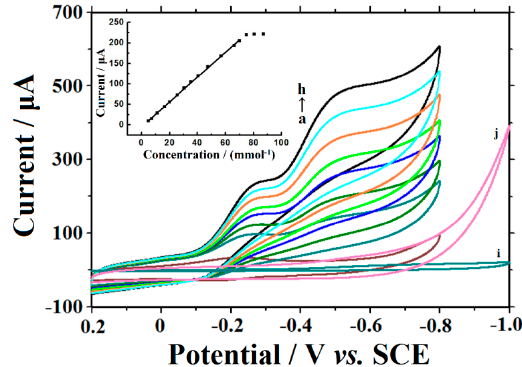
Figure 7. CV of CTS/CMS-Hb/CILE with 0, 15.0, 25.0, 35.0, 45.0, 55.0, 65.0, 70.0 mmol ¨ L ´ 1 TCA (curves a Ñ h) and of CTS/CMS/CILE with of 0, 80.0 mmol ¨ L ´ 1 TCA (curves i and j), scan rate: